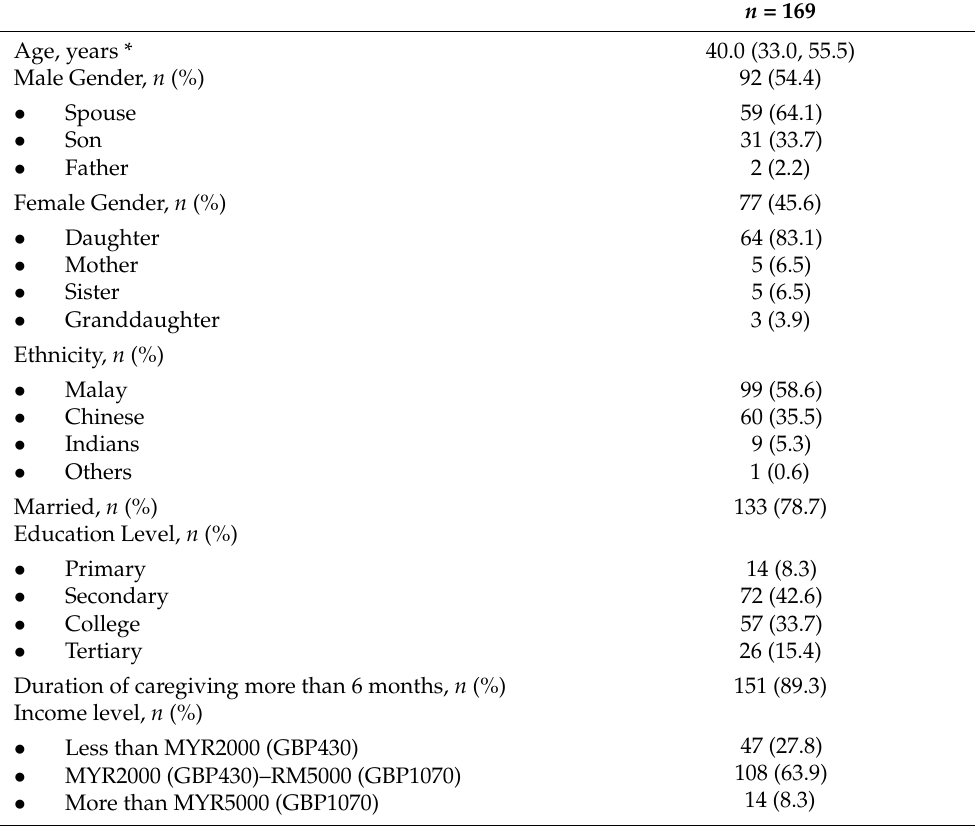
Table 3. Socio-demographic data of family